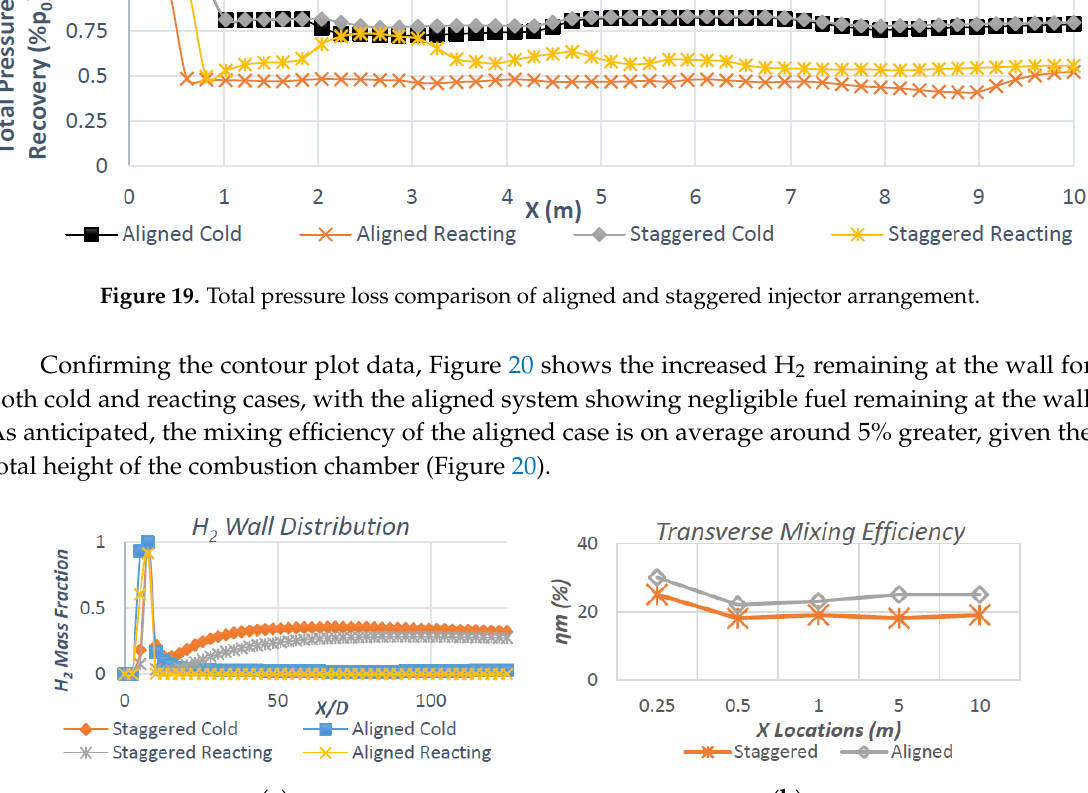
Figure 18. Bow shock extent in terms of flow field density (kg/m 3 ). ( a ) Staggered; ( b ) Aligned.